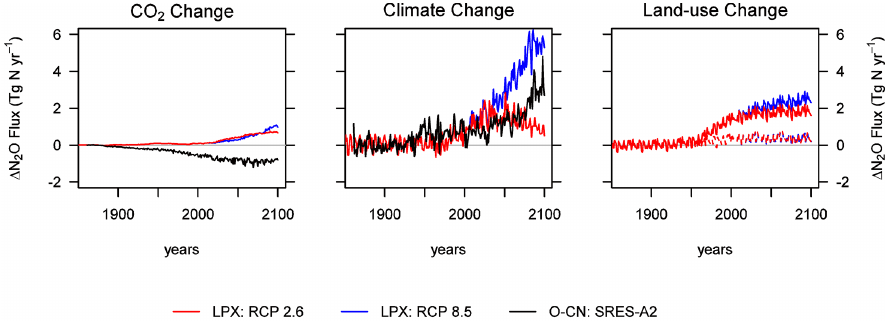
Figure 14. Changes in terrestrial N 2 O emissions from pre-industrial conditions to projected changes of the atmospheric CO 2 burden, climate, and land use, as simulated by the two global terrestrial biosphere models (LPX and O–CN), as in Fig. 13. Dashed lines in the land-use change panel refer to projected N 2 O emission without the change in fertilizer inputs associated with the RCP scenarios (Stocker et al.,